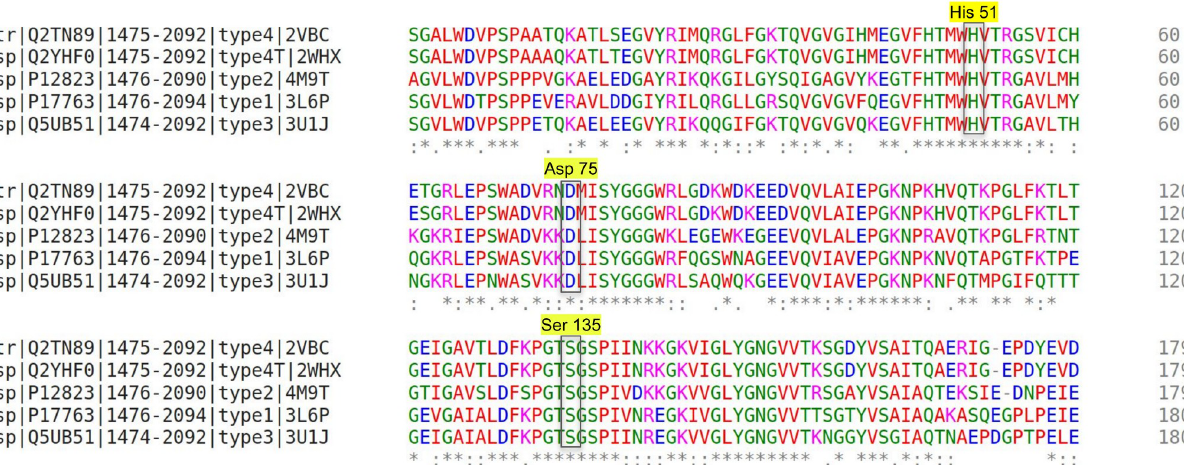
PLOS ONE | https://doi.org/10.1371/journal.pone.0257206 September 10,